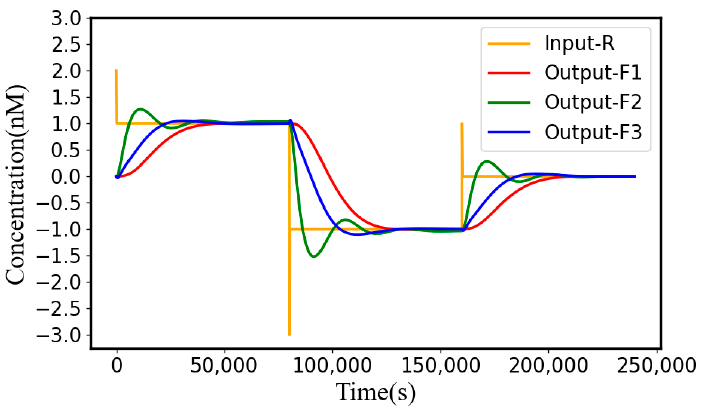
Figure 11. Output responses of three control systems